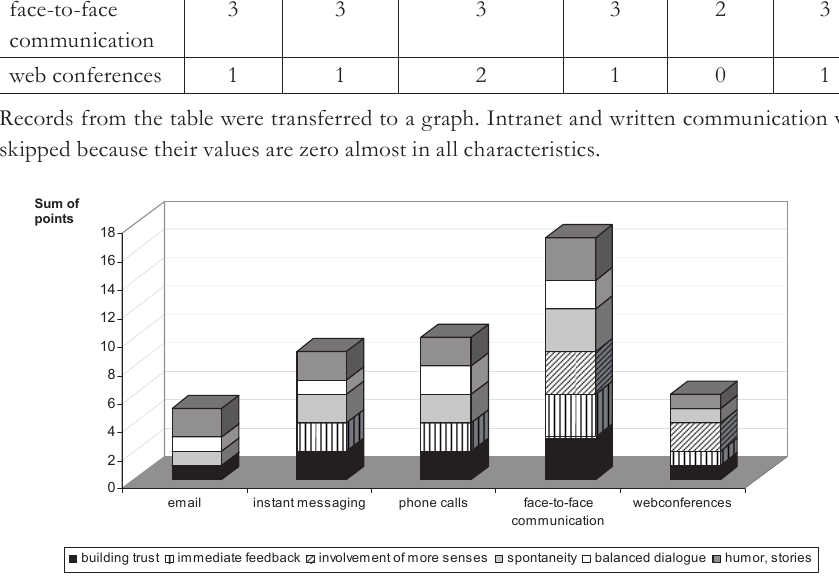
Fig. 1 - Assessment of Communication Tools in Key Requirements. Source: own